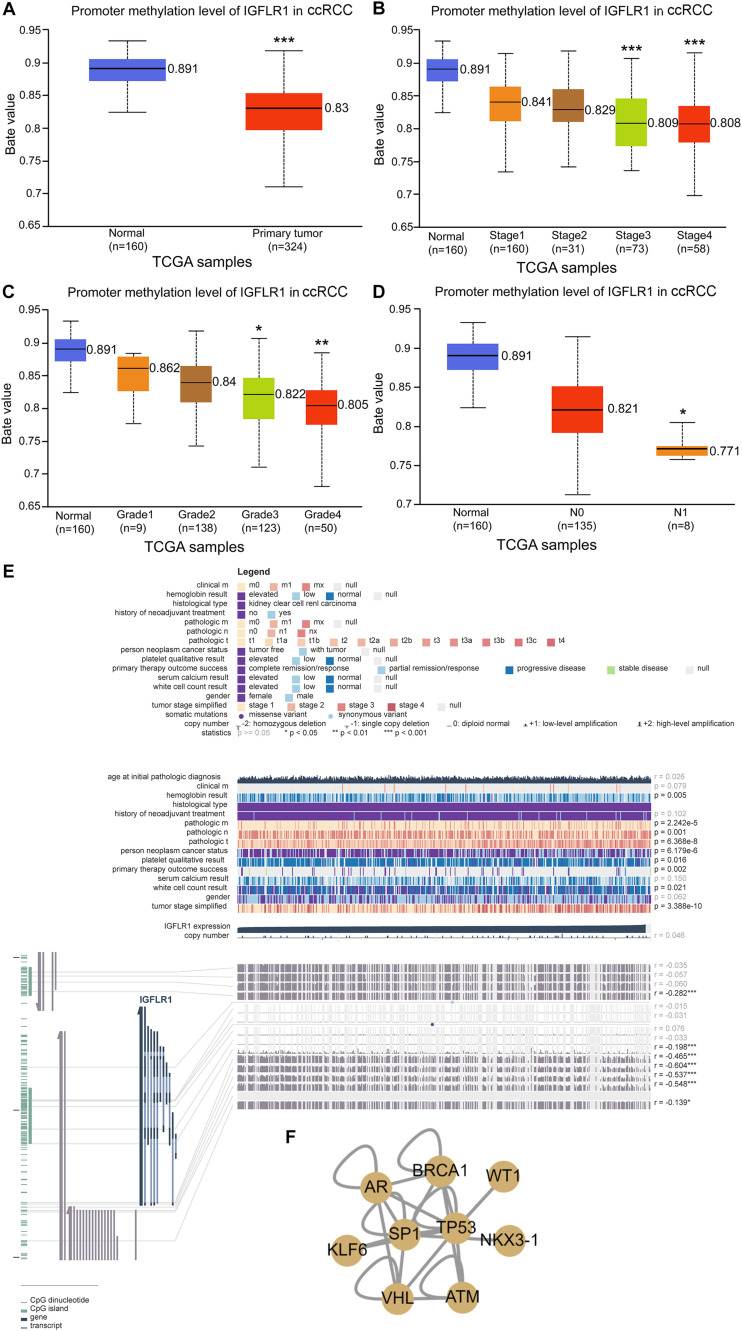
Methylation profile of IGFLR1. (A–D) IGFLR1 promoter methylation level in ccRCC of different sample type, stage, Grade and nodal metastasis status. All the advanced tumors were compared with stage1, Grade1 and N0 tumors. [Note: The Beta value indicates level of DNA methylation ranging from 0 (unmethylated) to 1 (fully methylated). Different beta value cut-off has been considered to indicate hyper-methylation (Beta value: 0.7–0.5) or hypo-methylation (Beta-value: 0.3–0.25)]. (E) The correlation between IGFLR1 expression level and DNA methylation, copy number and clinical data in ccRCC in detail. (F) Transcription factor (TF) regulatory network. (n.s.: not significant, * p < 0.05, ** p < 0.01, *** p < 0.001).